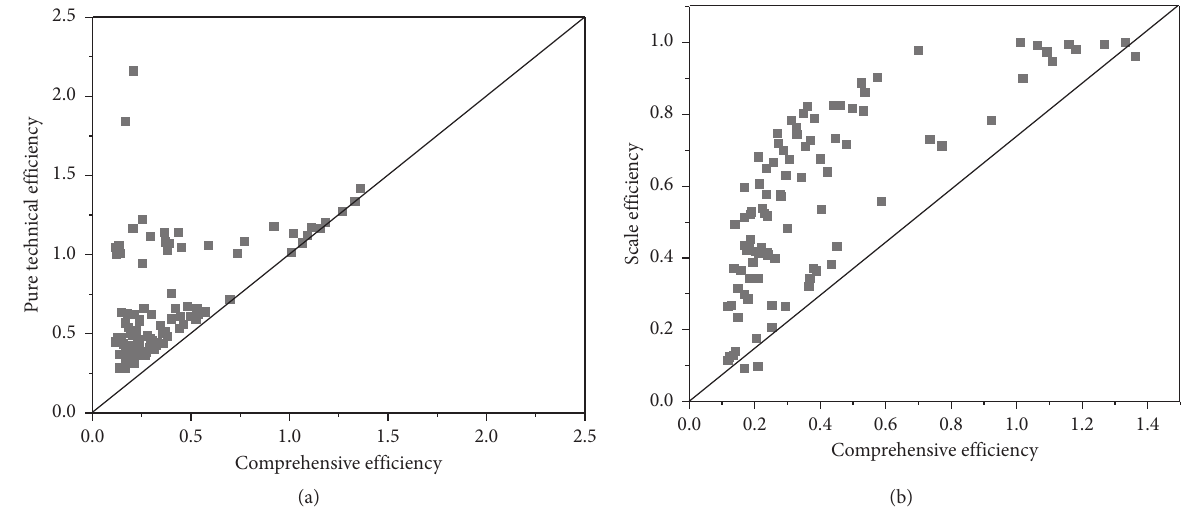
Figure 7: Analysis of the contribution of decomposition efficiency to total efficiency. (a) Comprehensive efficiency-pure technical efficiency. (b) Comprehensive efficiency-scale